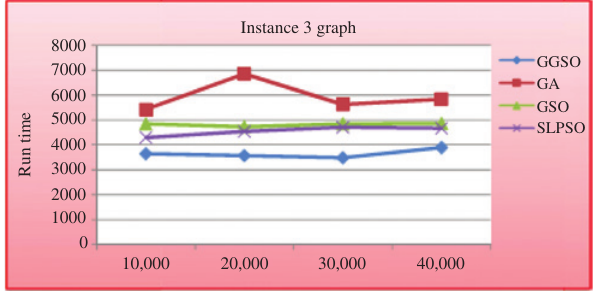
Figure 8: Runtime Performance of Instance